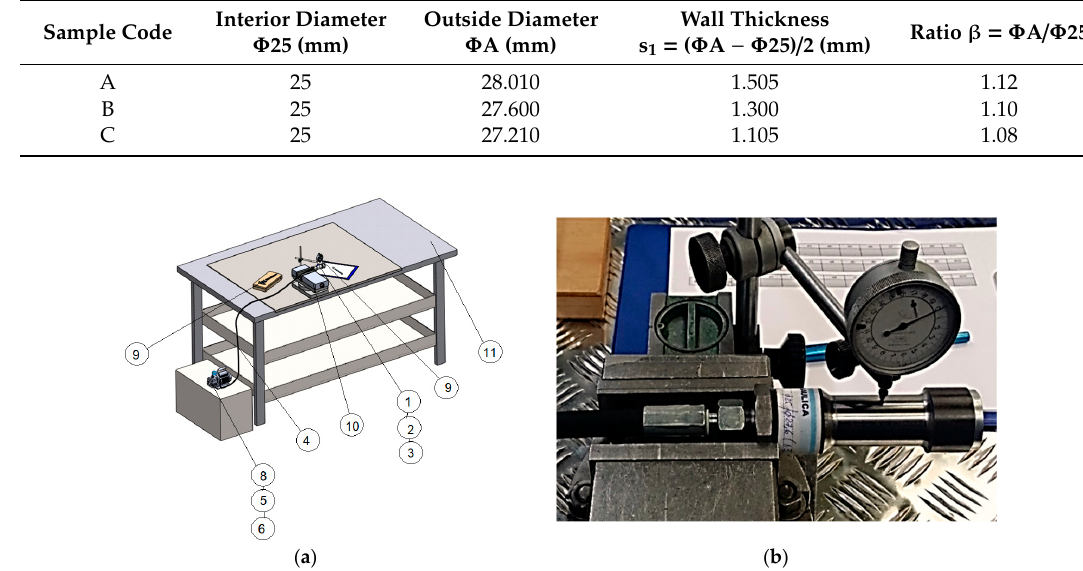
Figure 4. The experimental bench used for cyclic loading. ( a ) The design of the experimental setup (1: sample; 2: joint hex-nipple M118x1.5; 3: metallic cork with gasket; 4: hydraulic hose; 5: T-shaped connector; 6: faucet type KHB-D/4’’; 8: electric pump; 9: measuring device; 10: sample fastener; 11: flat and rigid table; ( b ) measuring samples during the test.